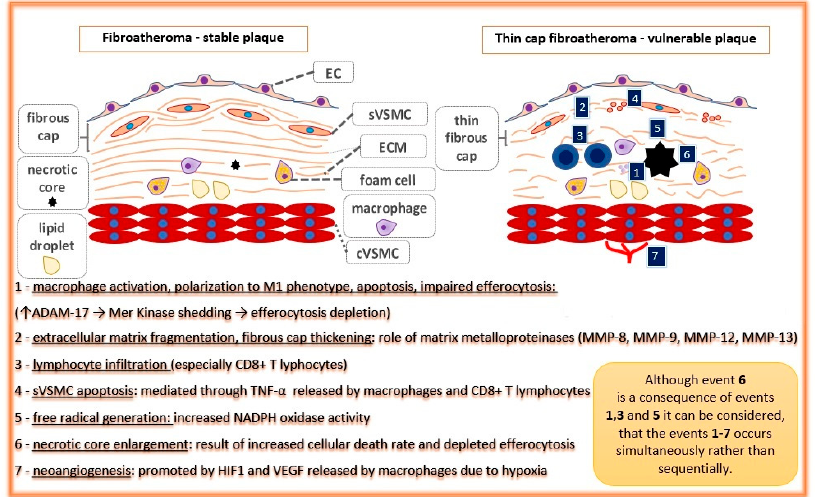
Figure 2. Pathophysiological processes and events leading to atherosclerotic plaque destabilization (events 1–7 in blue boxes). EC: endothelial cell; cVSMC: vascular smooth muscle cell, contractile phenotype; sVSMC: vascular smooth muscle cell, synthetic phenotype; ECM: extracellular matrix.